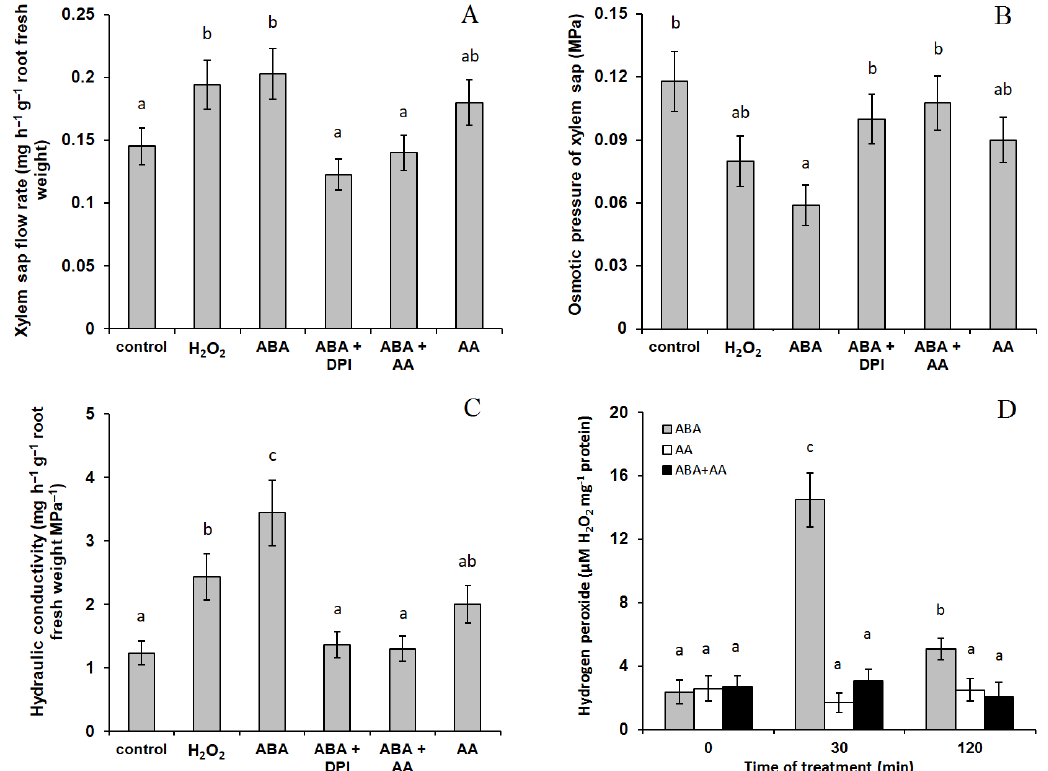
Figure 1. The effect of 10 µ M ABA and its combination with 10 µ M diphenylene iodonium chloride (ABA + DPI) and 10 mM ascorbic acid (ABA + AA) on the flow rate of xylem sap ( A ), its osmotic pressure ( B ) and hydraulic conductivity ( C ) of detached roots of barley plants; ( D ) production of hydrogen peroxide in roots treated with ABA, AA and ABA + AA. Data represent the mean ± S.E. ( n = 6). Significantly different means for each variable are labelled with different letters ( p ≤ 0.05, LSD test). Int. J. Mol. Sci. 2021 , 22 , x FOR PEER REVIEW